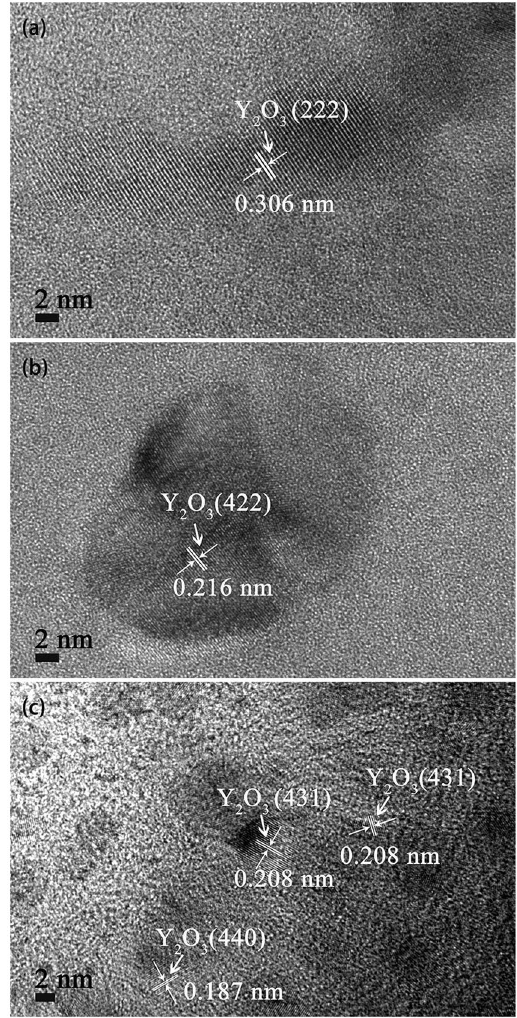
Figure 6. HRTEM images of Y 2 O 3 particles within tungsten grain of W-Y 2 O 3 alloy fabricated by ( a ) and ( b ) traditional wet chemical method and subsequent SPS, ( c ) improved wet chemical method and subsequent